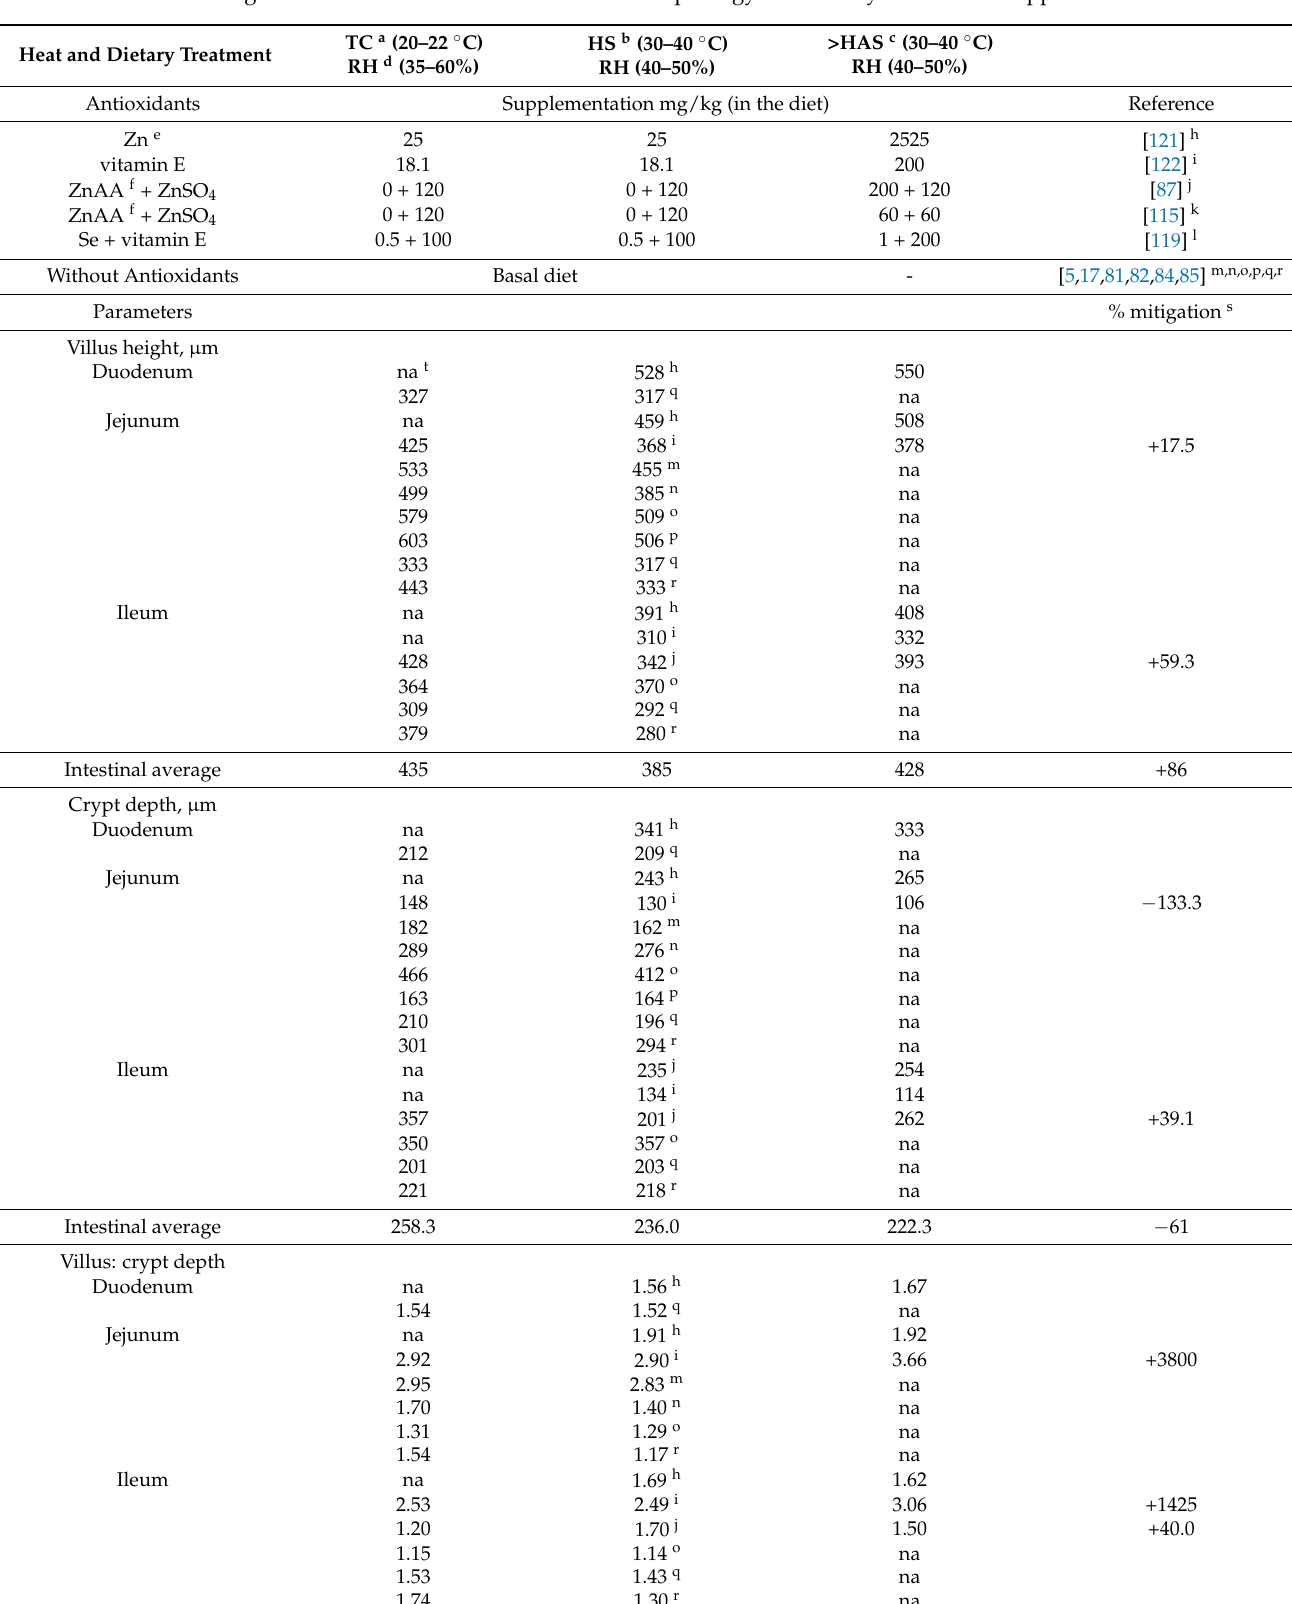
Table 4. Mitigation of heat stress effect on intestinal morphology and TER by antioxidant